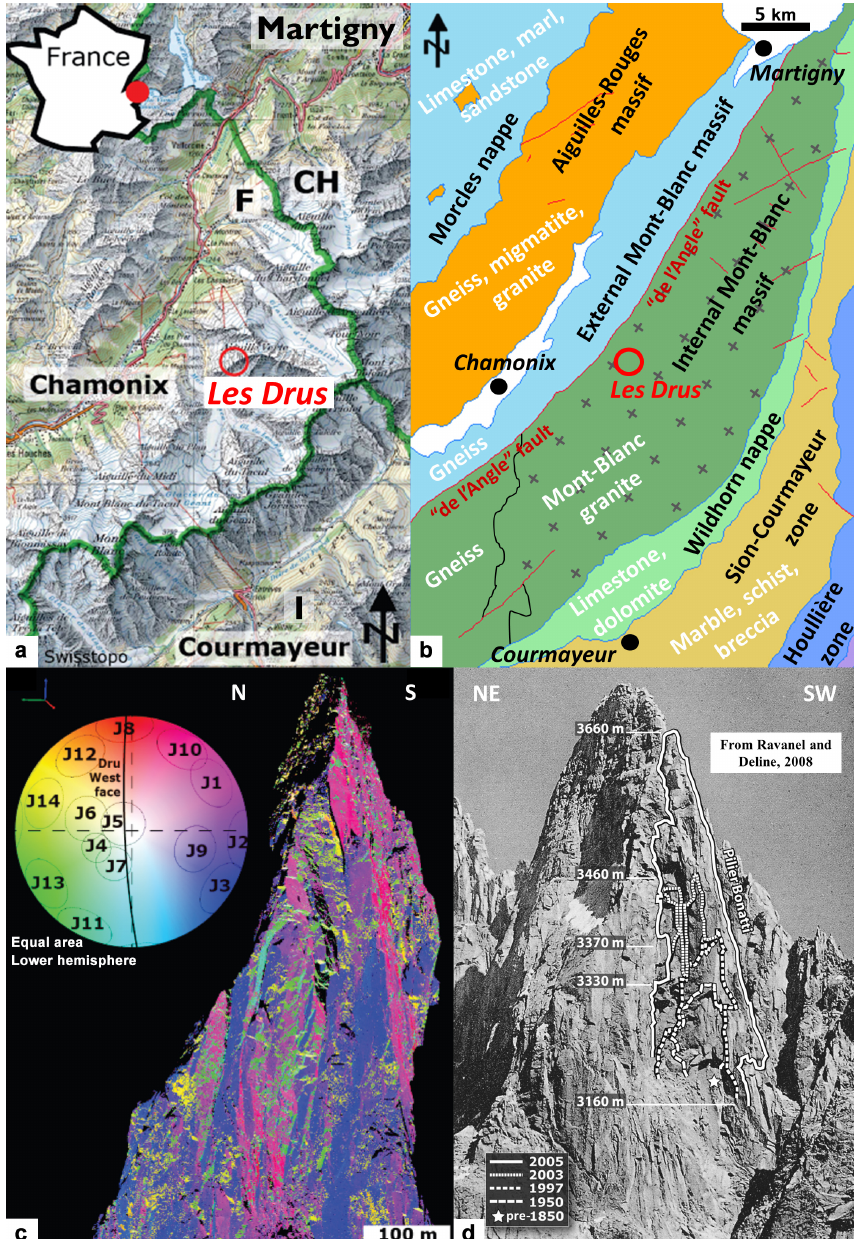
Figure 1. Location and geological setting of the study area. (a) Location of the Drus within the Chamonix valley (Mont Blanc massif, France); background map: Swisstopo. (b) Geotectonic map of the study area (map modified after Steck et al., 2000). (c) 2005/2011 merged lidar point cloud and discontinuities measured in the Drus west face. Each color corresponds to the stereographic projection of the poles of joint sets (Schmidt stereonet, Coltop3D software). (d) Photo-comparison reconstruction of the main historical rockfall events that occurred on the Drus west face from 1850 onwards (figure modified after Ravanel and Deline,